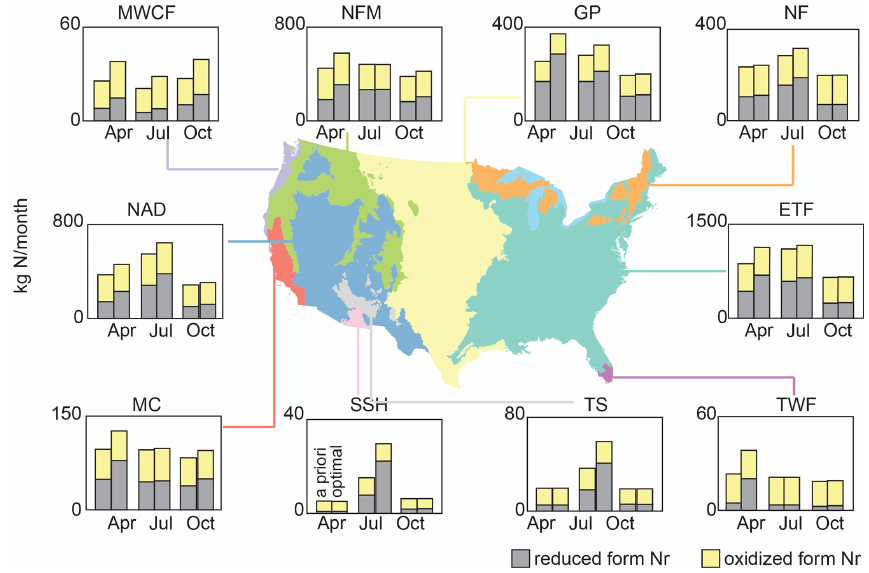
Figure 6. The changes in the simulated monthly reactive nitrogen (Nr) deposition amount in protected areas for biodiversity conservation caused by the emission adjustment in April, July, and October. For each month, the left bar is for the a priori deposition amounts and the right bar is for the optimized deposition amounts. The deposition is grouped for 10 Level I ecoregions defined by the Commission for Environmental Cooperation, including Northern Forests (NF), Great Plains (GP), Northwestern Forested Mountains (NFM), Marine West Coast Forest (MWCF), North American Deserts (NAD), Mediterranean California (MC), Southern Semiarid Highlands (SSH), Temperate Sierras (TS), and Tropical Wet Forests